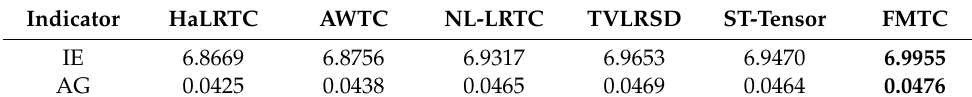
Figure 18. The time-series curves of six algorithms applied to one pixel from 2004 to 2006.